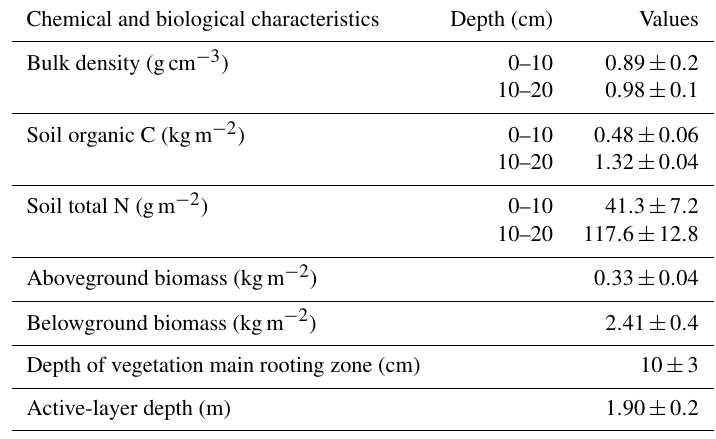
Table 1. Biomass and soil properties at the experiment